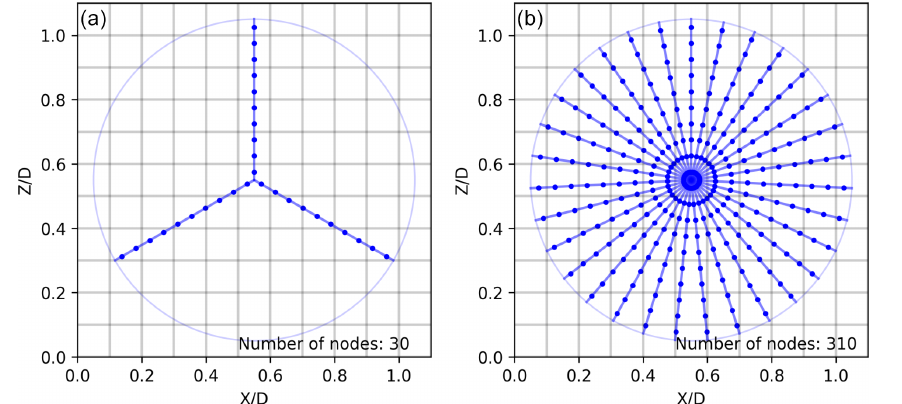
Figure 1. Example of the node distribution strategy on lines for the ALM (a) and the ADM (b) . In this example, a coarse mesh of 10 cells along the diameter is taken to make the node distribution clearer for the